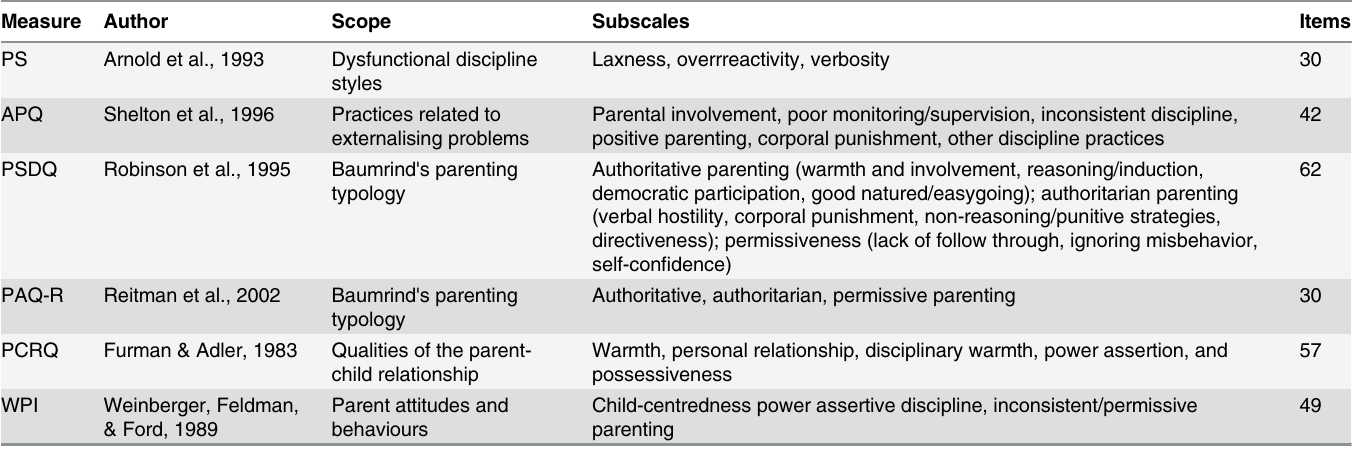
Table 1. Parenting Measures Included in the Initial Item